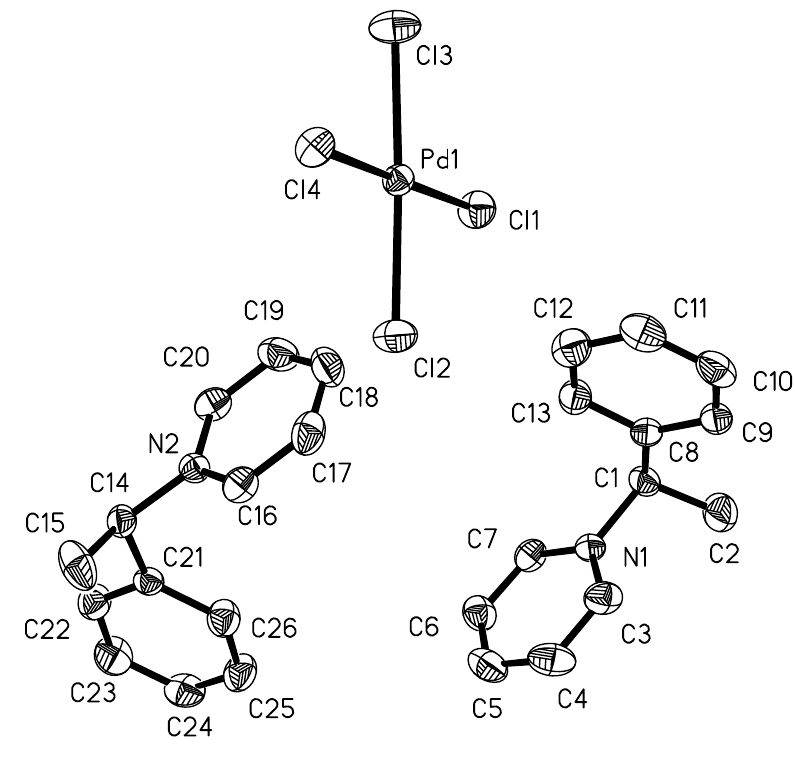
Figure 3. Molecular structure and atom labelling scheme of 2R with thermal ellipsoids drawn at the 50 % probability level (hydrogen atoms are not